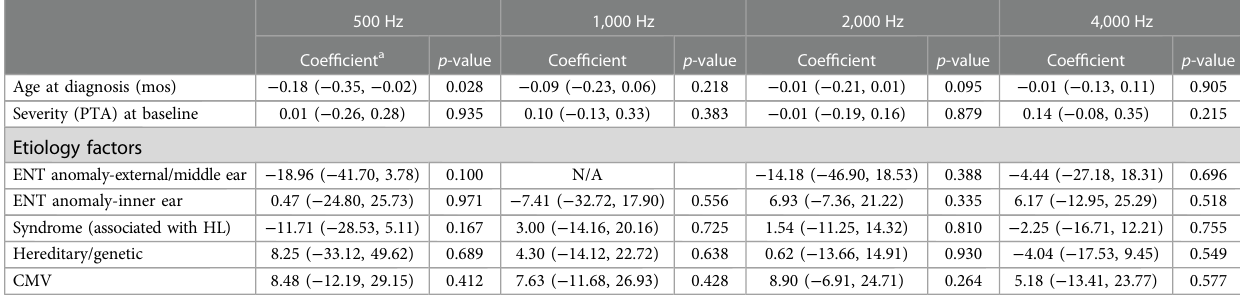
TABLE 3 Factors associated with amount of deterioration in hearing across frequencies ( n